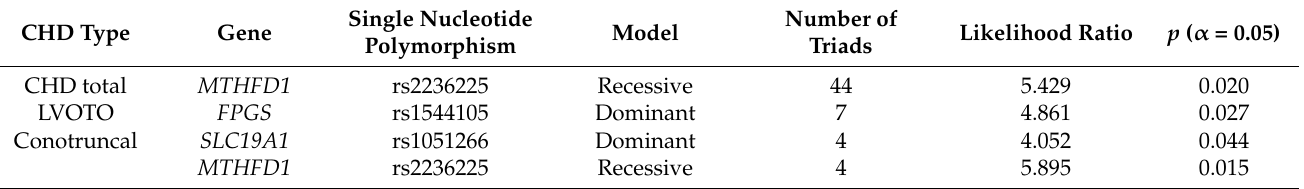
Table 4. Likelihood ratio test best hits in the family triads. CHDs, congenital heart